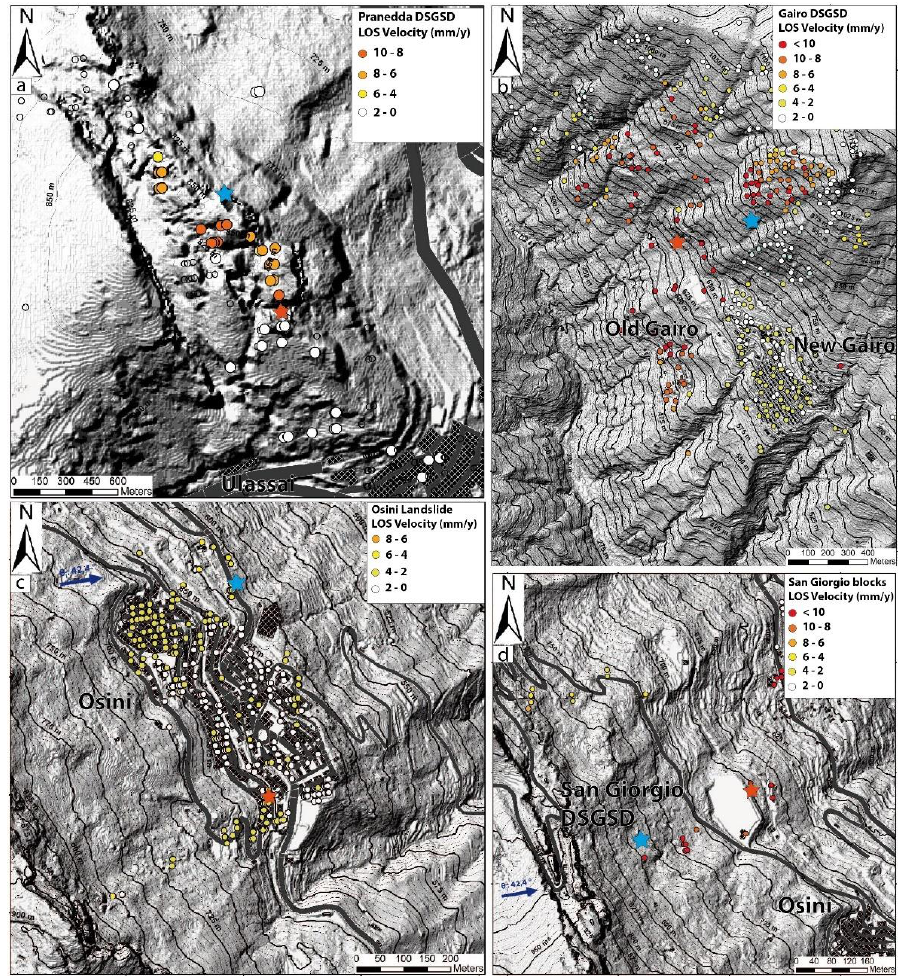
Figure 5. Analysis of the focus areas with InSAR data. The points represent high-coherence perma- nent scatters located on buildings, rocky outcrops, and blocks of large rock avalanches. The stars represent the PSs used to analyze the time series shown in Figure 6. ( a ) Bruncu Pranedda lateral spread. ( b ) Gairo DGSD. ( c ) Osini landslide. ( d ) San Giorgio paleo-rock